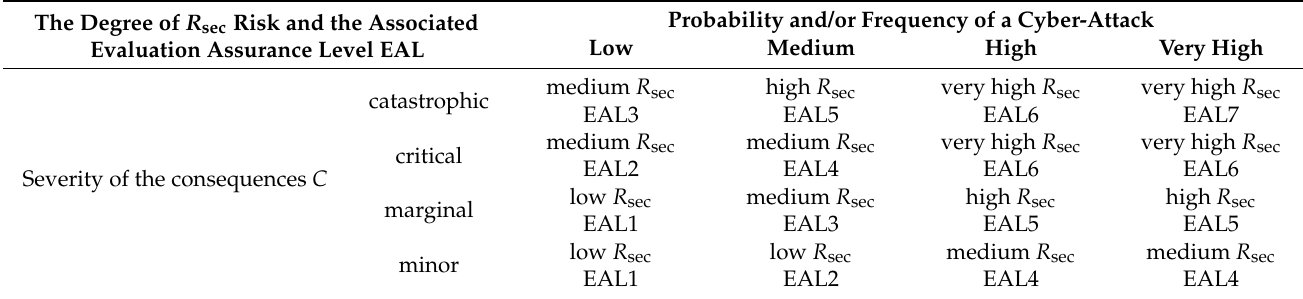
Table 6. Risk Matrix Regarding Information Security Issues in a Critical Infrastructure Facility.